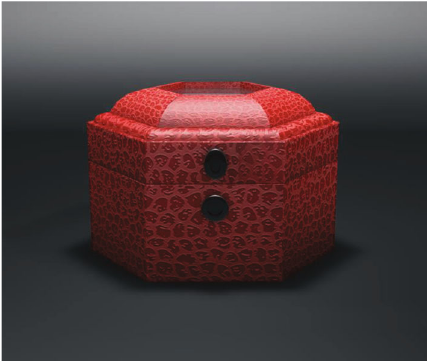
Figure 3: Ruby ring packaging design